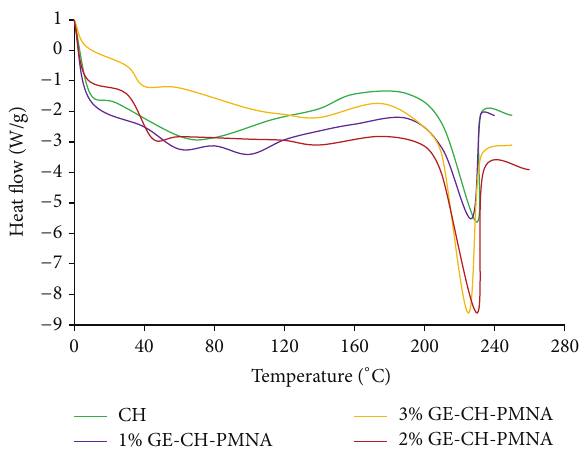
Figure 6: DSC thermograms of CH, 1% GE-CH-PMNA, 2% GE- CH-PMNA, and 3%